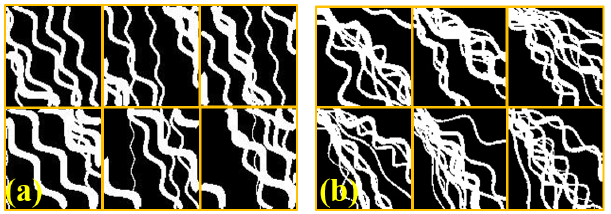
Figure 9. Examples of training images. ( a ) Training images for sand bodies of meandering river main channel; ( b ) training images for delta plain distributary channel. channel; ( b ) training images for delta plain distributary